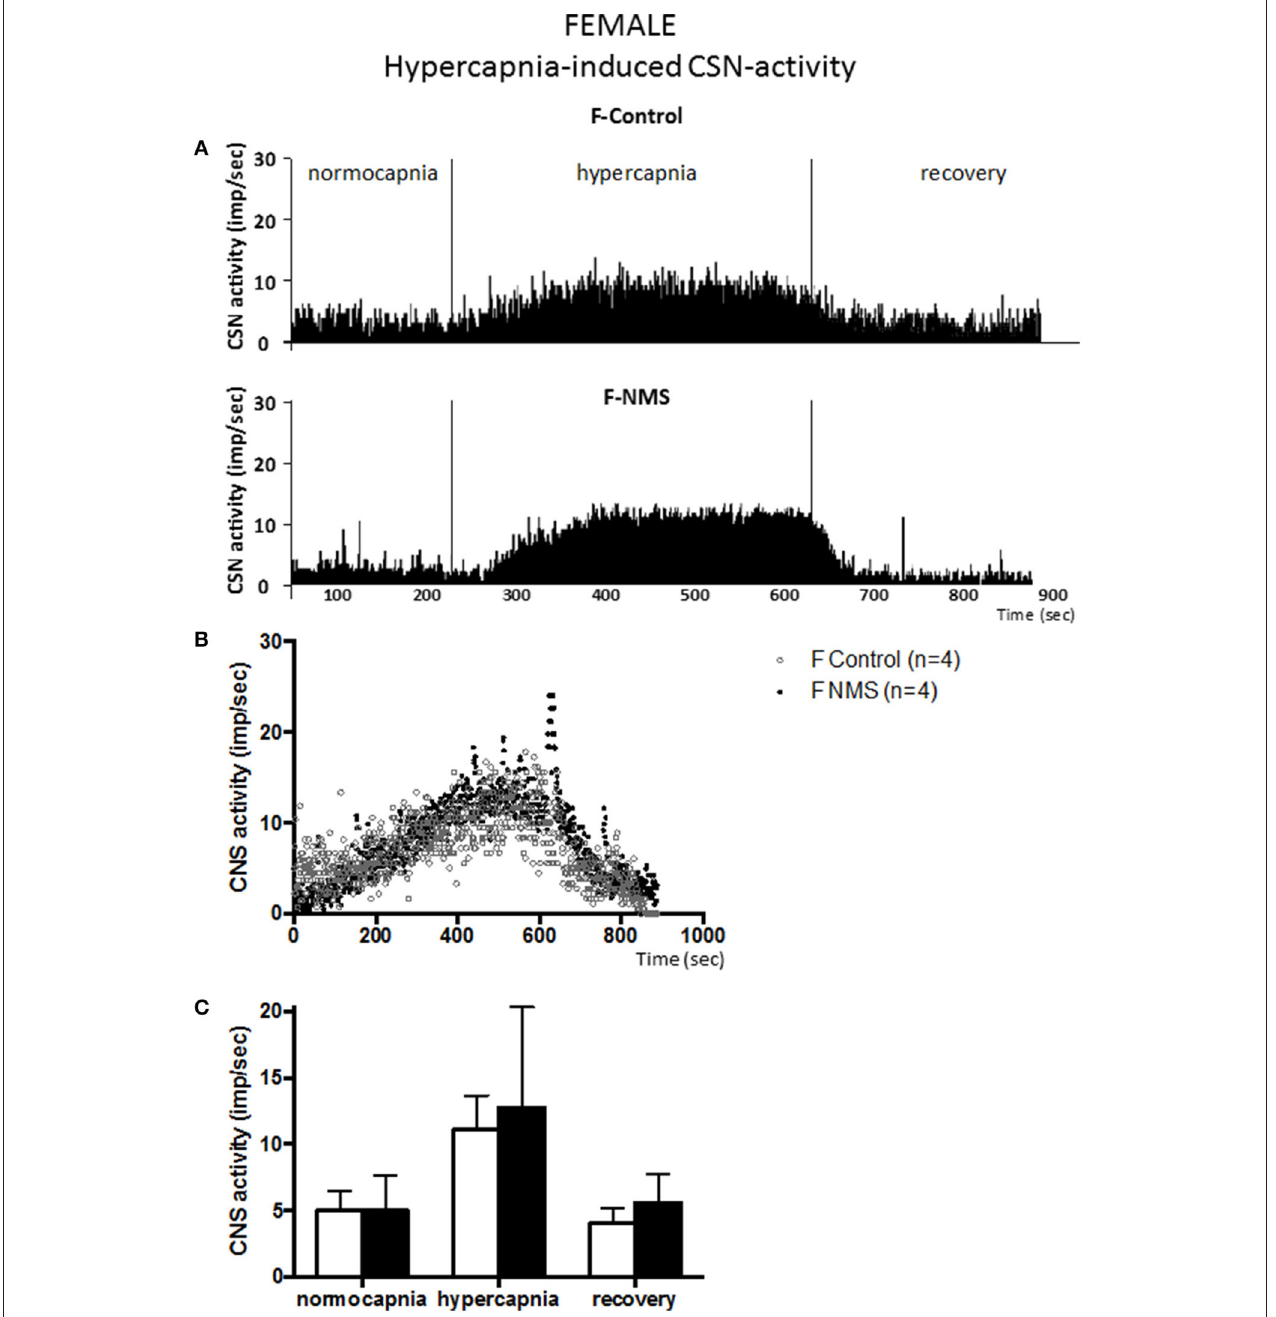
FIGURE 4 | Neonatal maternal separation (NMS) does not alter the hypercapnic carotid sinus nerve (CSN) response to hypercapnia in female rats. (A) Original recordings comparing CSN activity from ex vivo preparations of perfused carotid body/CSN from control and NMS females under hyperoxia (FiO 2 = 0.95), hypercapnia (FiCO 2 = 0.30) and hyperoxia after hypoxia (recovery). (B) Comparison of the mean carotid sinus nerve activity (imp/sec) over the course of the hypercapnic protocol between carotid bodies from control (open squares; n = 4) and NMS rats (black squares; n = 4). Hypercapnia begins at T = 0 and is maintained until T = 500s (end of plateau phase), followed by hyperoxic recovery; each data point represents the mean value on a second by second basis. (C) Histograms comparing mean CSN activity for each specific experimental condition between control (white bars; n = 4) and NMS (black bars; n = 4) female rats. Data are reported as means ± SD